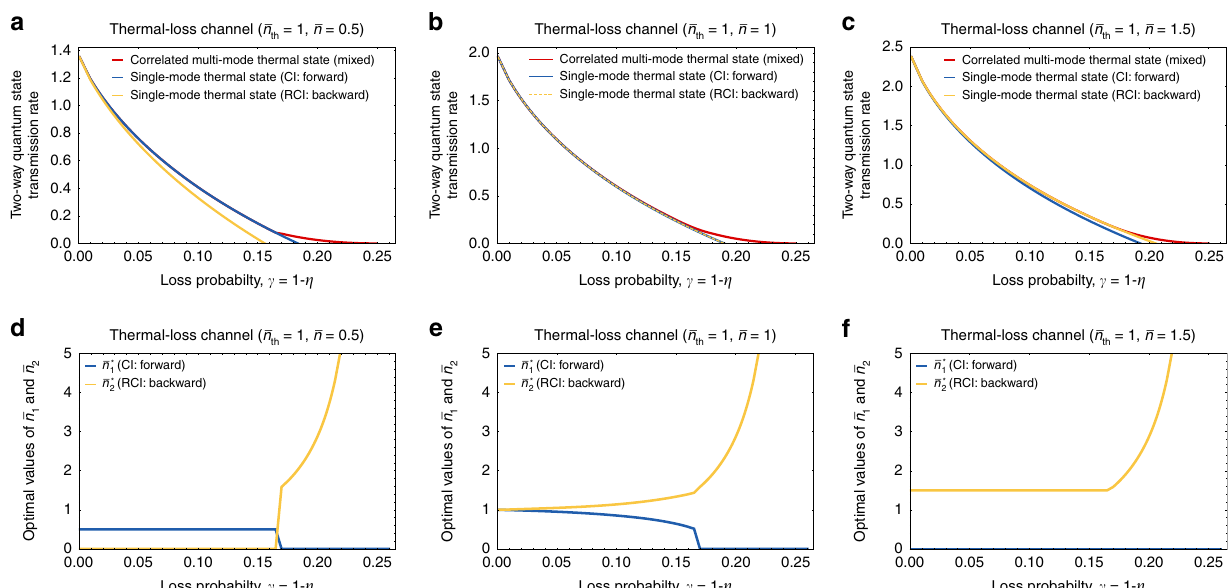
Fig. 4 Achievable two-way quantum state transmission rate of thermal-loss channels. We plot the achievable two-way quantum state transmission rate of a thermal-loss channel N½ η ; (cid:2) n the blue and yellow lines, respectively, represent the coherent information I respect to single-mode thermal states. The achievable two-way quantum state transmission rate of correlated multimode thermal states (red lines in ( a – c )) was evaluated by taking ð x ? ; (cid:2) n ? Theorem 2). In d – f , the optimal values (cid:2) n ?